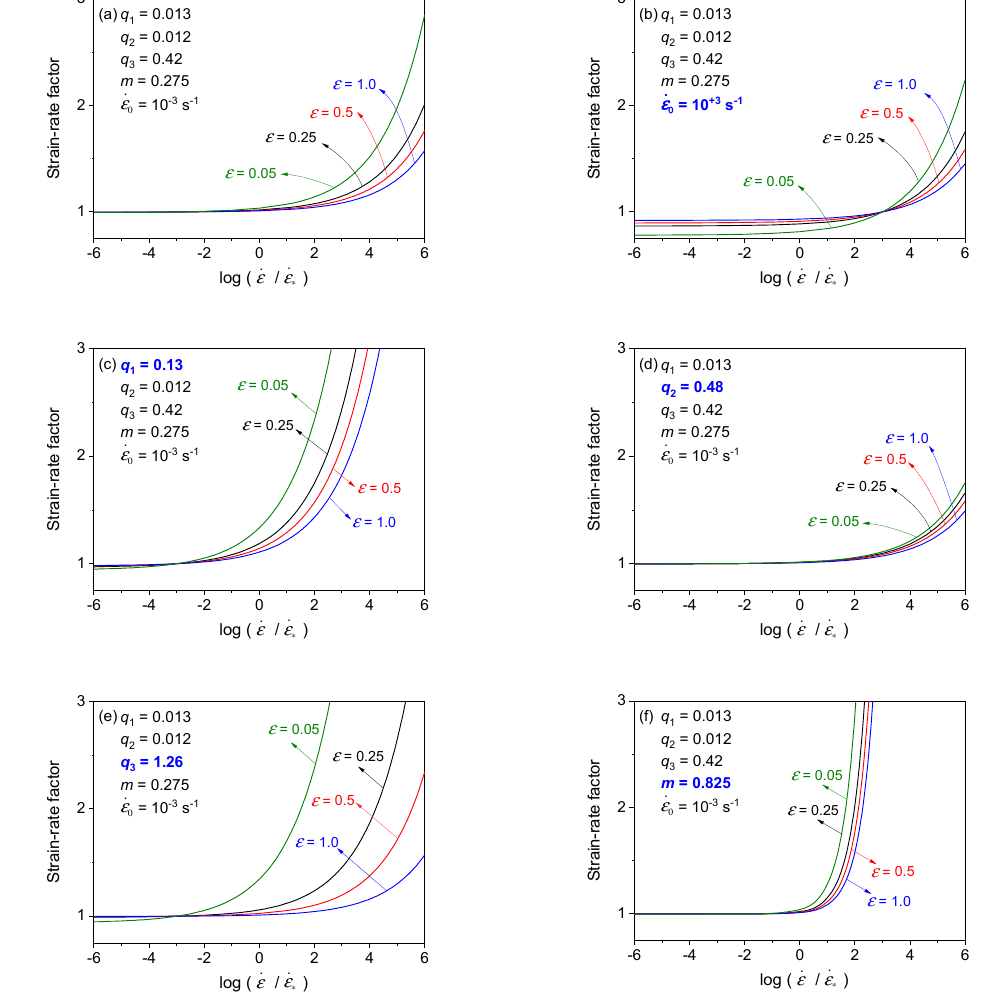
Figure 7. ( a ) Lim–Huh rate factor for 4340 steel ( q 1 = 0.013, q 2 = 0.012, q 3 = 0.420, and m = 0.275 when ε 0 =10 − 3 s − 1 ). Change in curve shapes as ( b ) ε 0 increases to 10 +3 s − 1 ; ( c ) q 1 increases ten times to 0.13, ( d ) q 2 increases 40 times to 0.48; ( e ) q 3 increases three times to 1.26; ( f ) m increases three times to